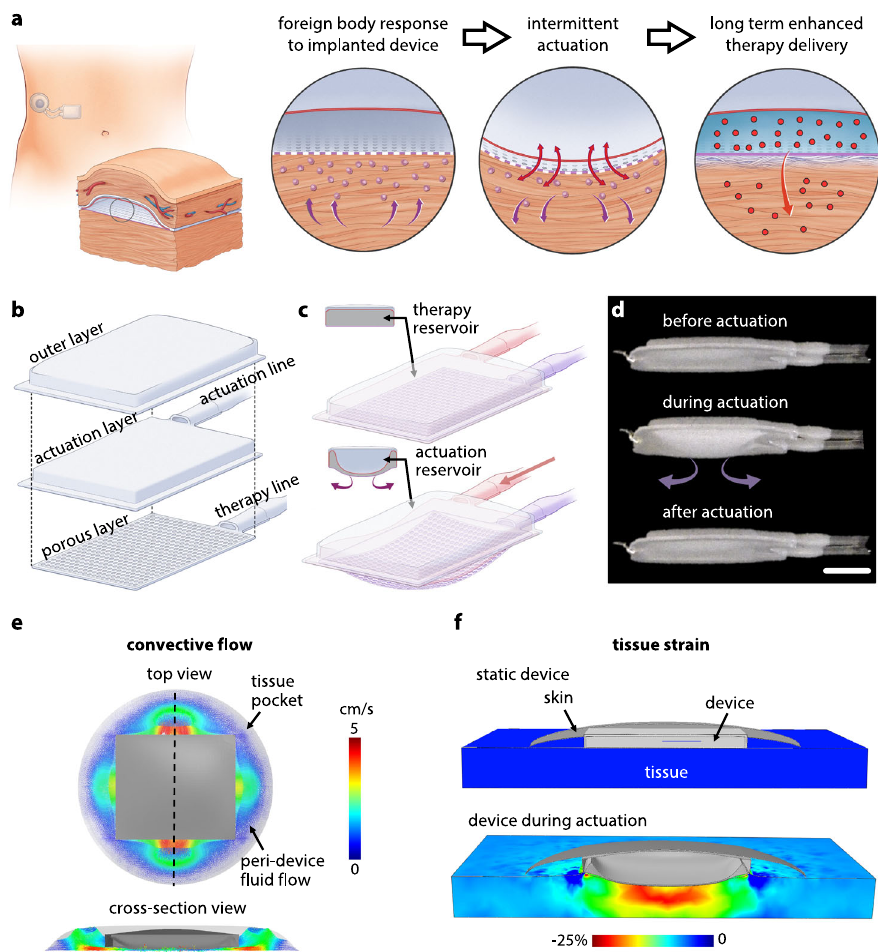
Fig. 1 | Design of soft transport augmenting reservoir (STAR). a Proposed mechanism of STAR: intermittent actuation attenuates the foreign body response, creating a favourable environment for the rapid long-term transport of macro- molecular drug therapy. b Exploded view showing the different layers comprising STAR. c De fl ection of the actuation and porous layers during actuation. d A